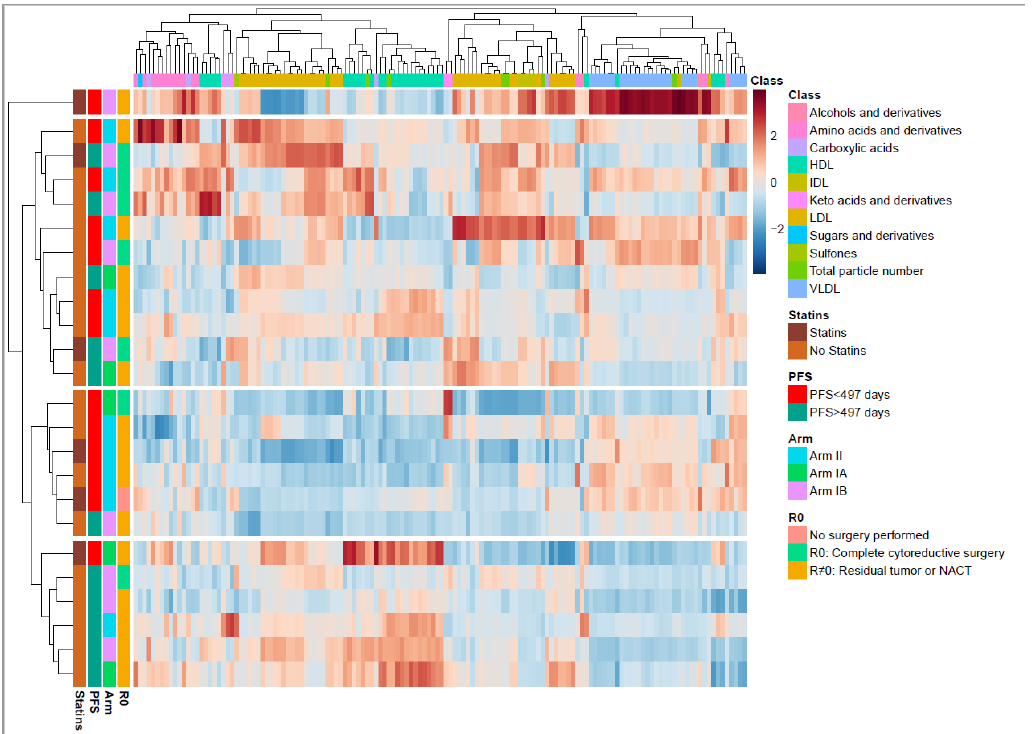
Figure 3. Overview of the metabolite and lipid composition in the total cohort at inclusion. Heatmap with unsupervised hierarchical clustering demonstrating the composition of metabolites and lipids. Each row represents one patient. The blocks to the left are color coded according to the different relevant subgroups (right). The metabolite and lipoprotein classes are shown at the top. Color scale represents a lower (blue) or higher (red) concentration of a metabolite or lipoprotein subfraction. The middle-boxed area in the heatmap indicates a clustering of patients with short progression-free survival (PFS), the majority with residual tumor. The lower boxed area shows a clustering of patients with long PFS, the majority with residual tumor. The color scale is relative and scaled for inter- individual differences between the patients for each metabolite subfraction. PC, principal component; PFS, progression-free survival; HDL, high density lipoproteins; IDL, intermediate dense lipoproteins; LDL, low density lipoproteins; VLDL, very low density lipoproteins.